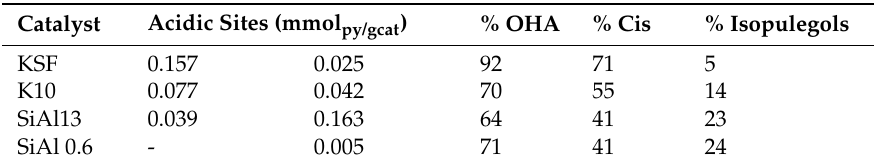
Table 2. Quantitative determination of acidic sites versus products distribution in the reaction of citronellal with